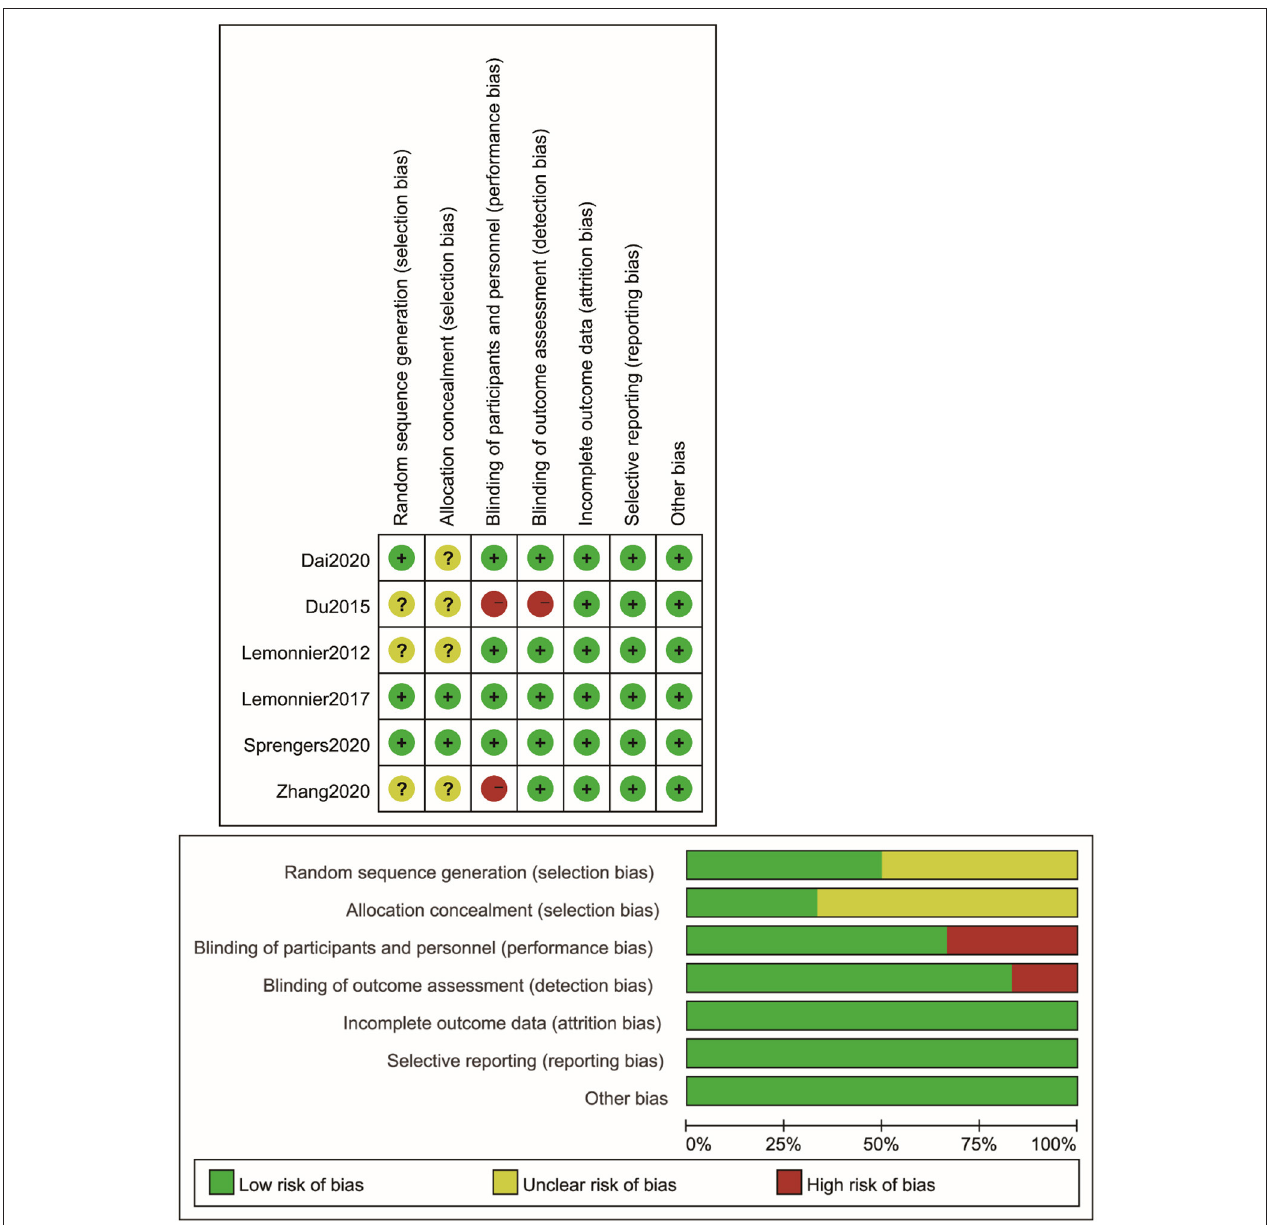
FIGURE 2 | Risk of bias in individual and across